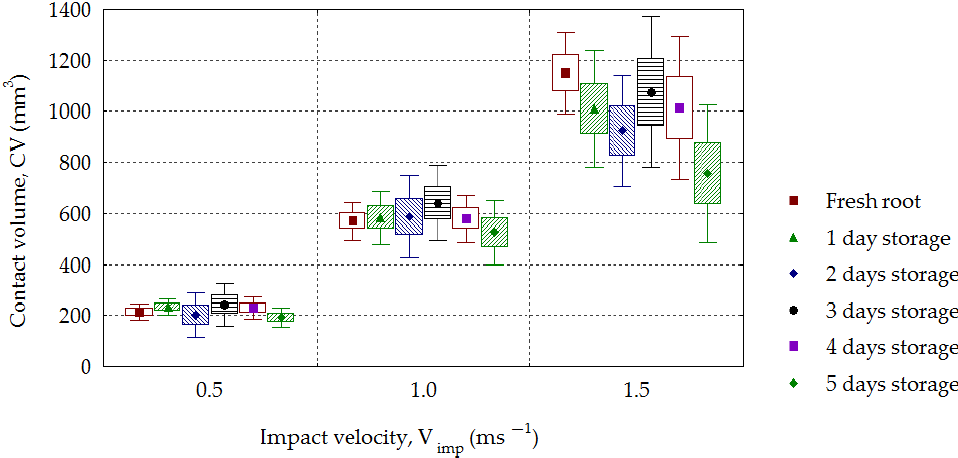
Figure 12. Dependence of absorbed energy related to mass ( E imp-v ) on the impact velocity ( V imp ) for the stored beets.